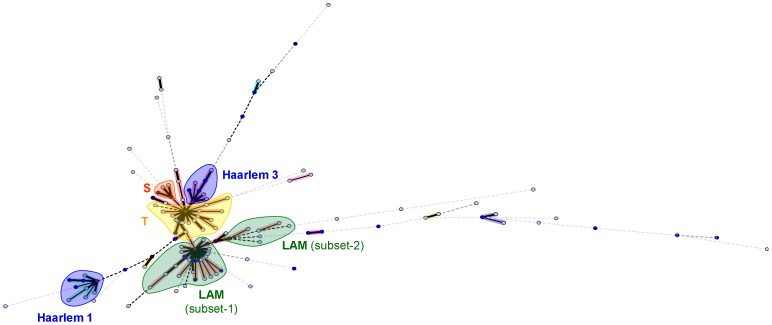
Minimum spanning tree (MST) showing evolutionary relationships among spoligotypes and lineages observed in Morocco.The length of the branches indicates the level of changes induced by loss or gain of spoligotype spacers to induce a shift from one allele to another (solid lines, single or 2 spacers changes; dotted lines, 3 or more spacer changes; color of circles shows number of isolates : sky-blue, 1 to 2 isolates; marine blue, 3 to 5 isolates; deep blue, 6 to 10 strains; brown, 11 to 20 strains; and red, >20 strains). Predominant genotypic lineages, sublineages and subsets are shown in distinct colors as follows: Haarlem (subdivided in Haarlem 1 and 3), LAM (subdivided in LAM subsets 1 and 2), S, and T (please refer to text for a detailed description).